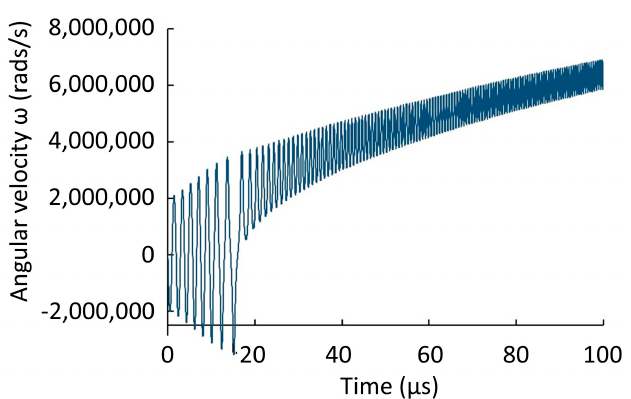
Figure 4. Estimated angular velocity in the first 10 − 4 s for 10 6 kg quark nugget with velocity v = 220 km/s, initial angle χ = 0.61 rad, initial angular velocity ω = 0, and passing through matter with mass density of 2300 kg/m 3 . Note the initial oscillation about 0 until a full rotation occurs, after which the angular velocity increases rapidly.